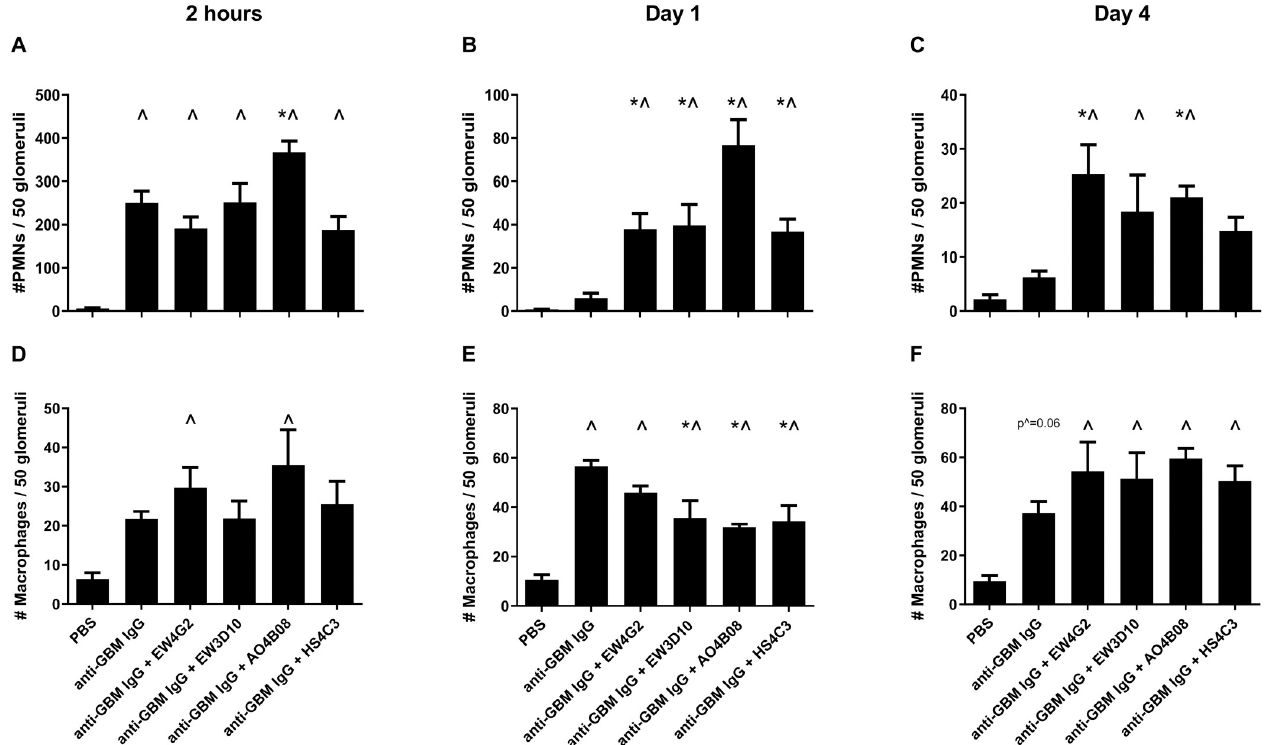
Fig 2. Co-injection of anti-HS antibodies in anti-GBM-induced glomerulonephritis differentially affects glomerular PMN and macrophage influx. Glomerular PMN influx after (A) 2 hours, (B) 1 day and (C) 4 days, and glomerular macrophage influx after (D) 2 hours, (E) 1 day and (F) 4 days analyzed by immunofluorescence staining. Results are expressed as means ± s.e.m. from four mice in each group. ^ P < 0.05 vs. PBS-injected mice. � P < 0.05 vs. anti-GBM IgG-injected mice.